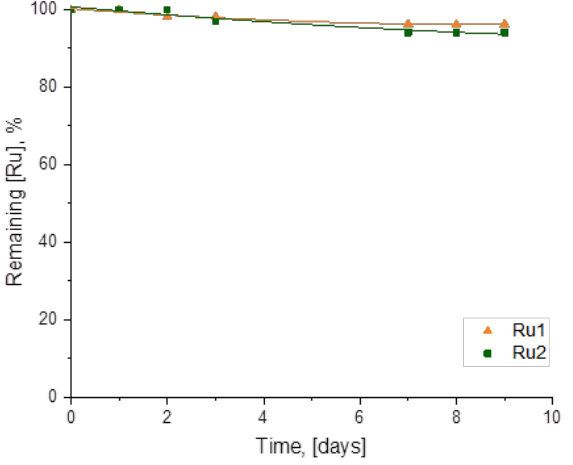
Figure 1. Results of the stability experiment for Ru1 and Ru2 in DCM- d 2 at room temperature.